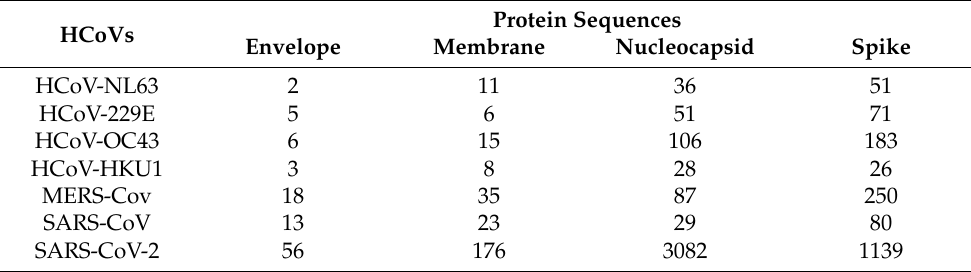
Table 1. Number of protein sequences for envelope, membrane, nucleocapsid, and spike proteins from HCoVs. The table shows the number of sequences used in our study that gave 100% query coverage and >90% conservation between HCoVs. Protein Sequences HCoVs Envelope Membrane